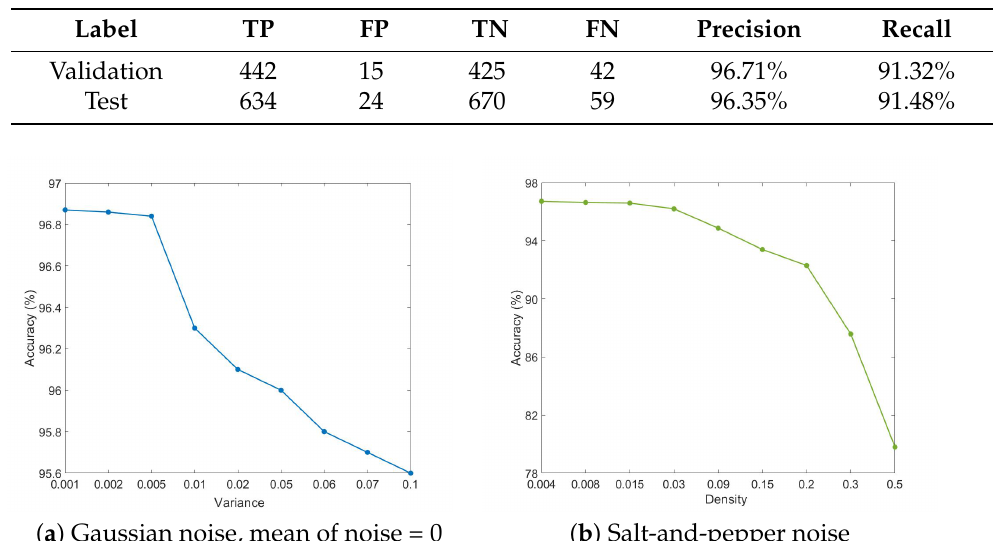
Table 8. The precision and recall of 3D-CNN.